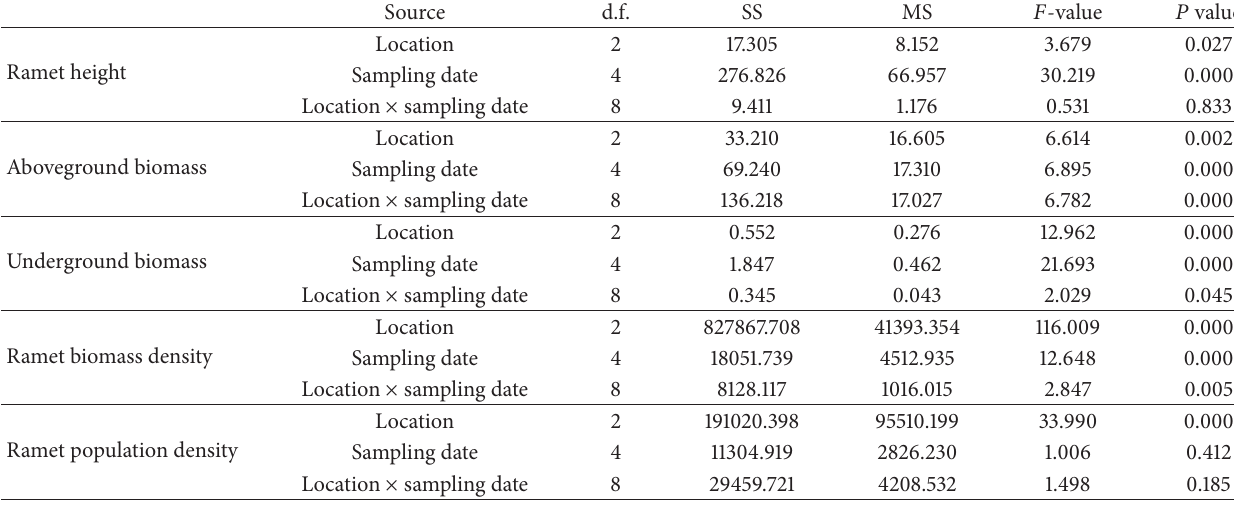
Table 2: Two-way ANOVA of the effects of location, sampling date, and their interactions on the ramet height, aboveground biomass, underground biomass, ramet biomass density, and ramet population density.